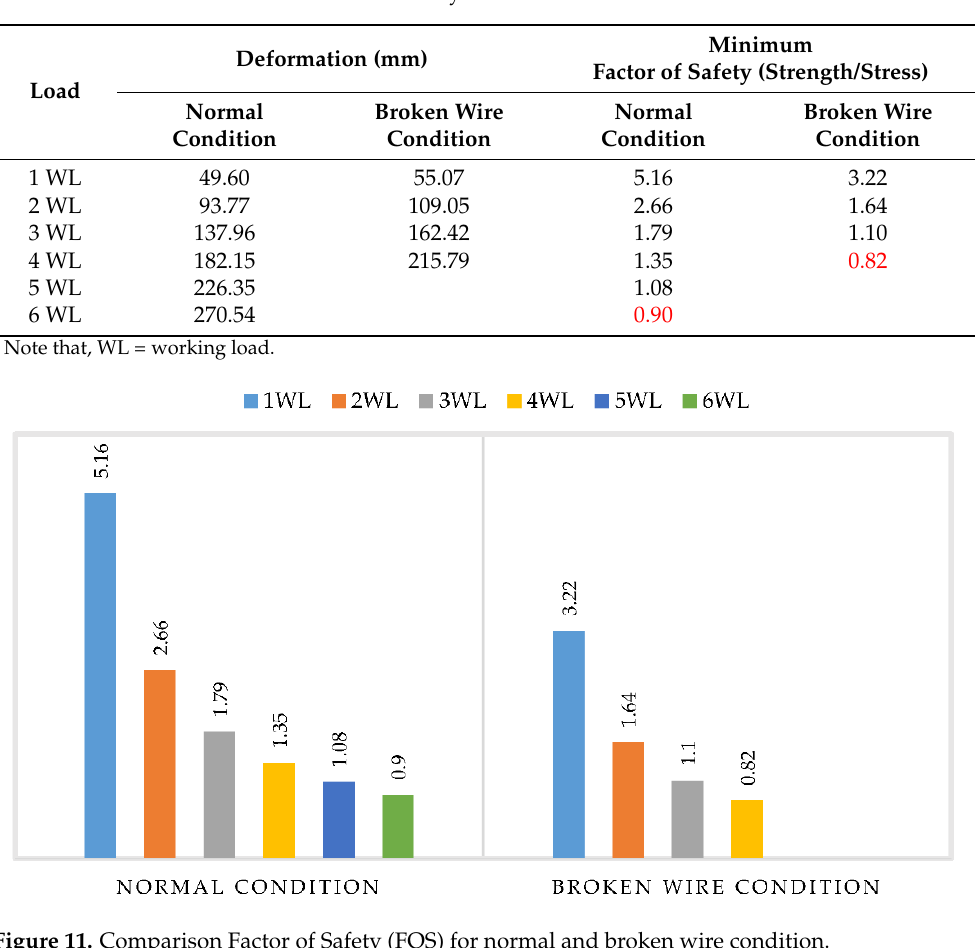
Table 6. Summarized minimum factor of safety for normal and broken wire condition.